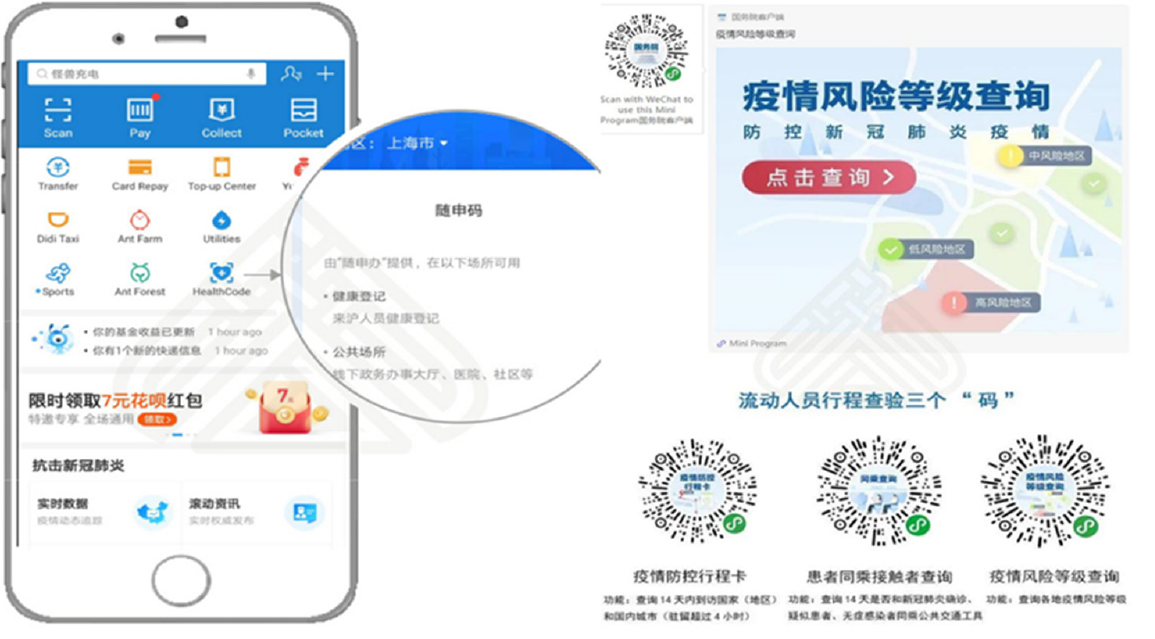
Figure 12. A screenshot of fellow passenger query tool in China [180,181].